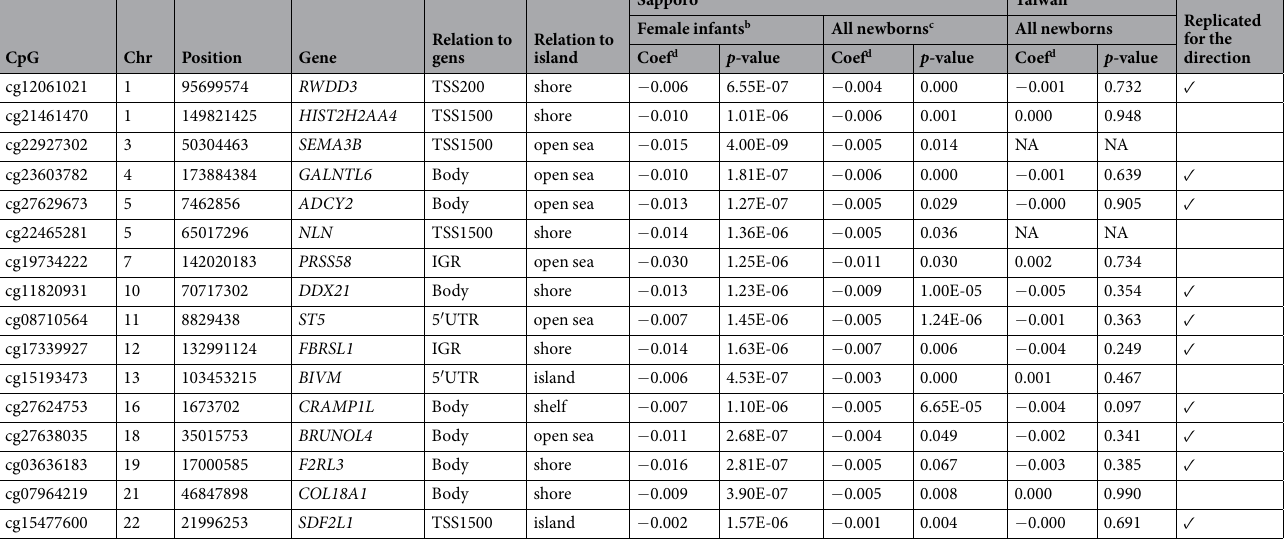
Table 3. 16 CpGs with DNA methylation levels in cord blood associated with BPA concentrations with FDR q < 0.05 in analysis for female infants. a Linear regression analyses adjusted for the sex of child were applied to determine the associations of DNA methylation levels with ln-transformed BPA levels in the Taiwan cohort. b Adjusted for maternal age, maternal educational levels, maternal pre-pregnancy BMI, maternal smoking during pregnancy, gestational age, and cord blood cell estimates. c Adjusted for maternal age, maternal educational levels, maternal pre-pregnancy BMI, maternal smoking during pregnancy, gestational age, infant sex, and cord blood cell estimates. d Partial regression coefficient indicates absolute DNA methylation change